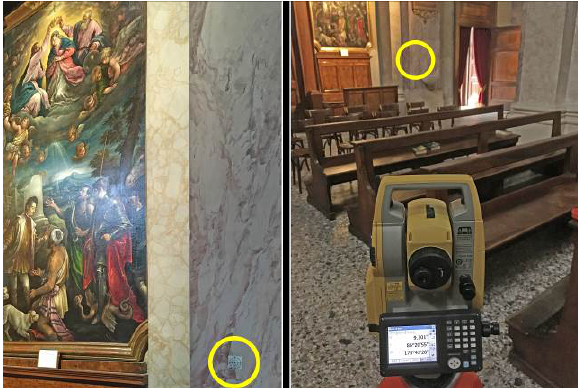
Figure 7. Internal church total-station network survey